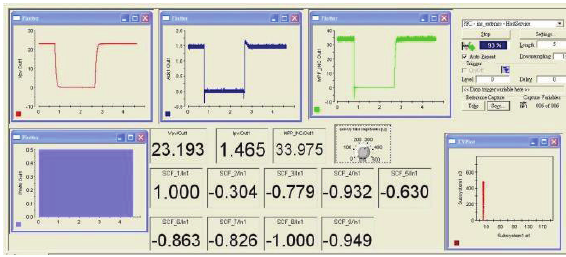
Figure 12: dSPACE real-time diagnosis